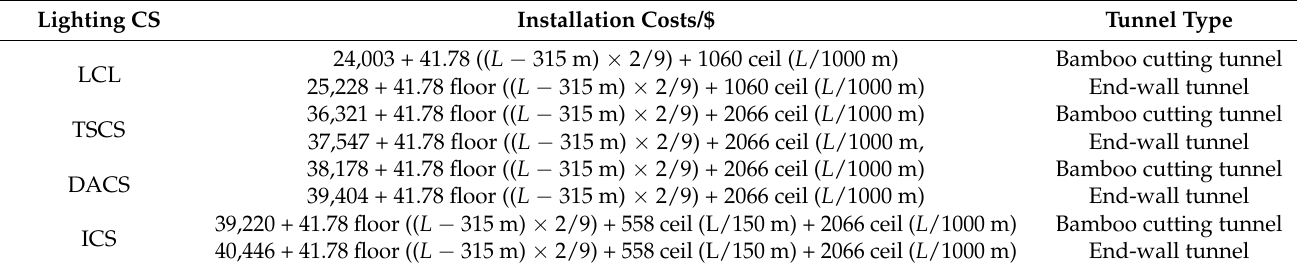
Table 7. Initial installation costs of tunnel lighting systems for various control strategies.